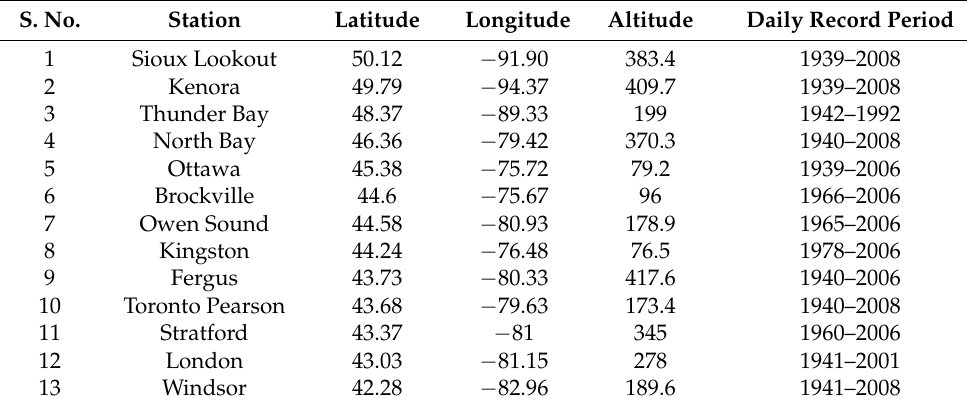
Table 1. Location and period of record for 13 stations across